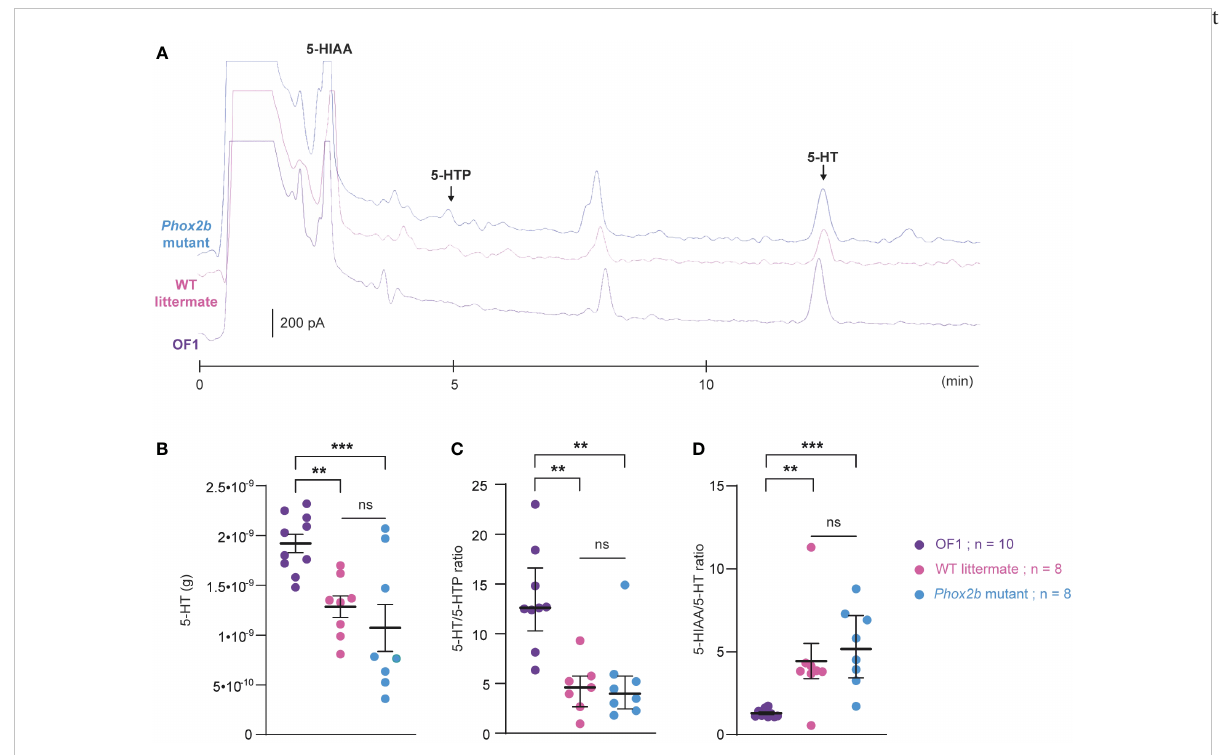
FIGURE 8 Ultra-high-performance liquid chromatography analysis of 5-HT contents and its related compounds, 5-HTP and 5-HIAA, in the medulla oblongata of Phox2b mutants, wildtype littermates and OF1 mice. (A) , Example of a chromatogram of medulla oblongata obtained from Phox2b mutants (blue; n=8), wildtype littermates (pink; n=8) and OF1 mice (purple; n=10) with indicated peaks of serotonin (5-HT), its precursor 5- hydroxytryptophan (5-HTP) and its metabolite 5-hydroxyindole acetic acid (5-HIAA). (B) , Scatter plots showing 5-HT quantity (g of 5-HT per medulla) with superimposed mean ± standard error of the mean. (C, D) , Scatter plots showing, respectively, 5-HT/5-HTP and 5-HIAA/5-HT ratio with median [Q1; Q3] superimposed in OF1 (purple fi lled circles), wildtype littermates (pink fi lled circles) and Phox2b mutants (blue fi lled circles). * Indicates a signi fi cant difference between OF1, Phox2b mutants and wildtype littermates (**p < 0.01 and ***p < 0.001; one-way analysis of variance or Kruskal-Wallis test followed by Benjamini, Krieger and Yekutieli ’ s multiple comparison test) ns, non signi fi